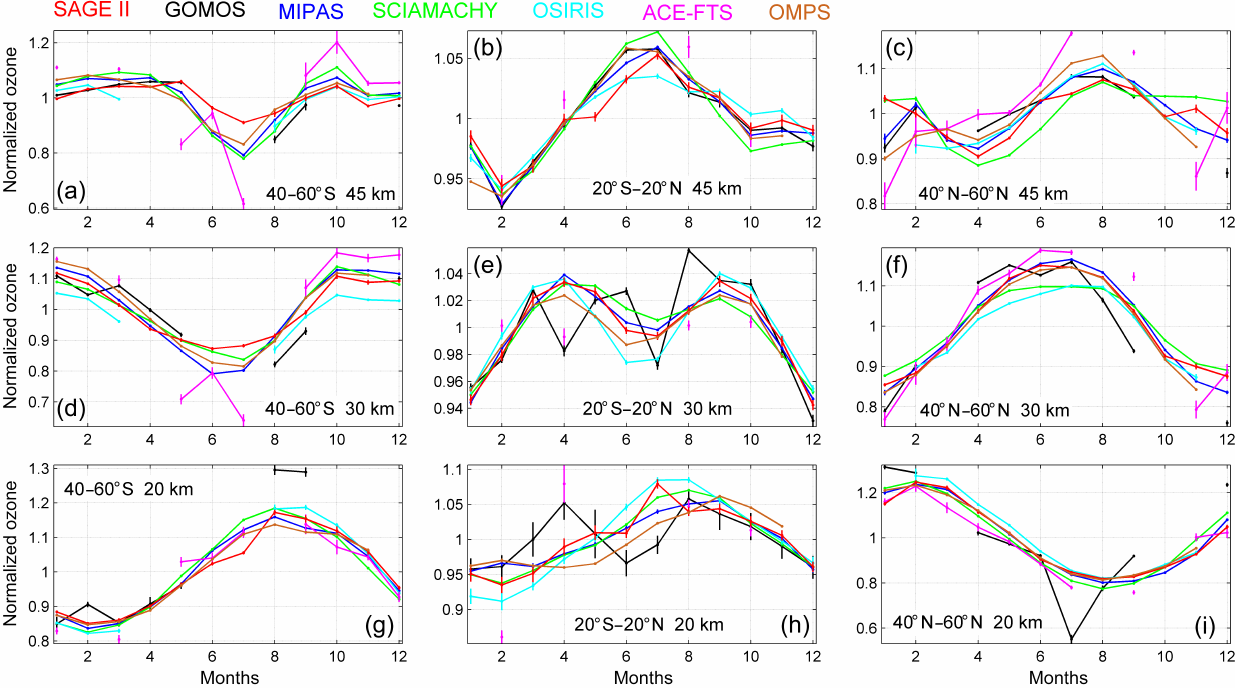
Figure 4. Ozone seasonal cycle normalized on the mean ozone value for latitudes 40–60 ◦ S (a, d, g) , 20 ◦ S–20 ◦ N (b, e, h) and 40–60 ◦ N (c, f, i) , for altitudes 45km (a–c) , 30km (d–f) and 20km (g–i) . Error bars are 2 σ uncertainties according to Eq.